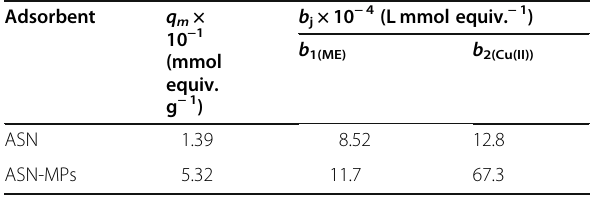
Table 4 Adsorption isotherms parameters binary Langmuir of ME and Cu(II) cations on ASN and ASN-MPs at 27 °C, pH 7, and 90 min of contact time